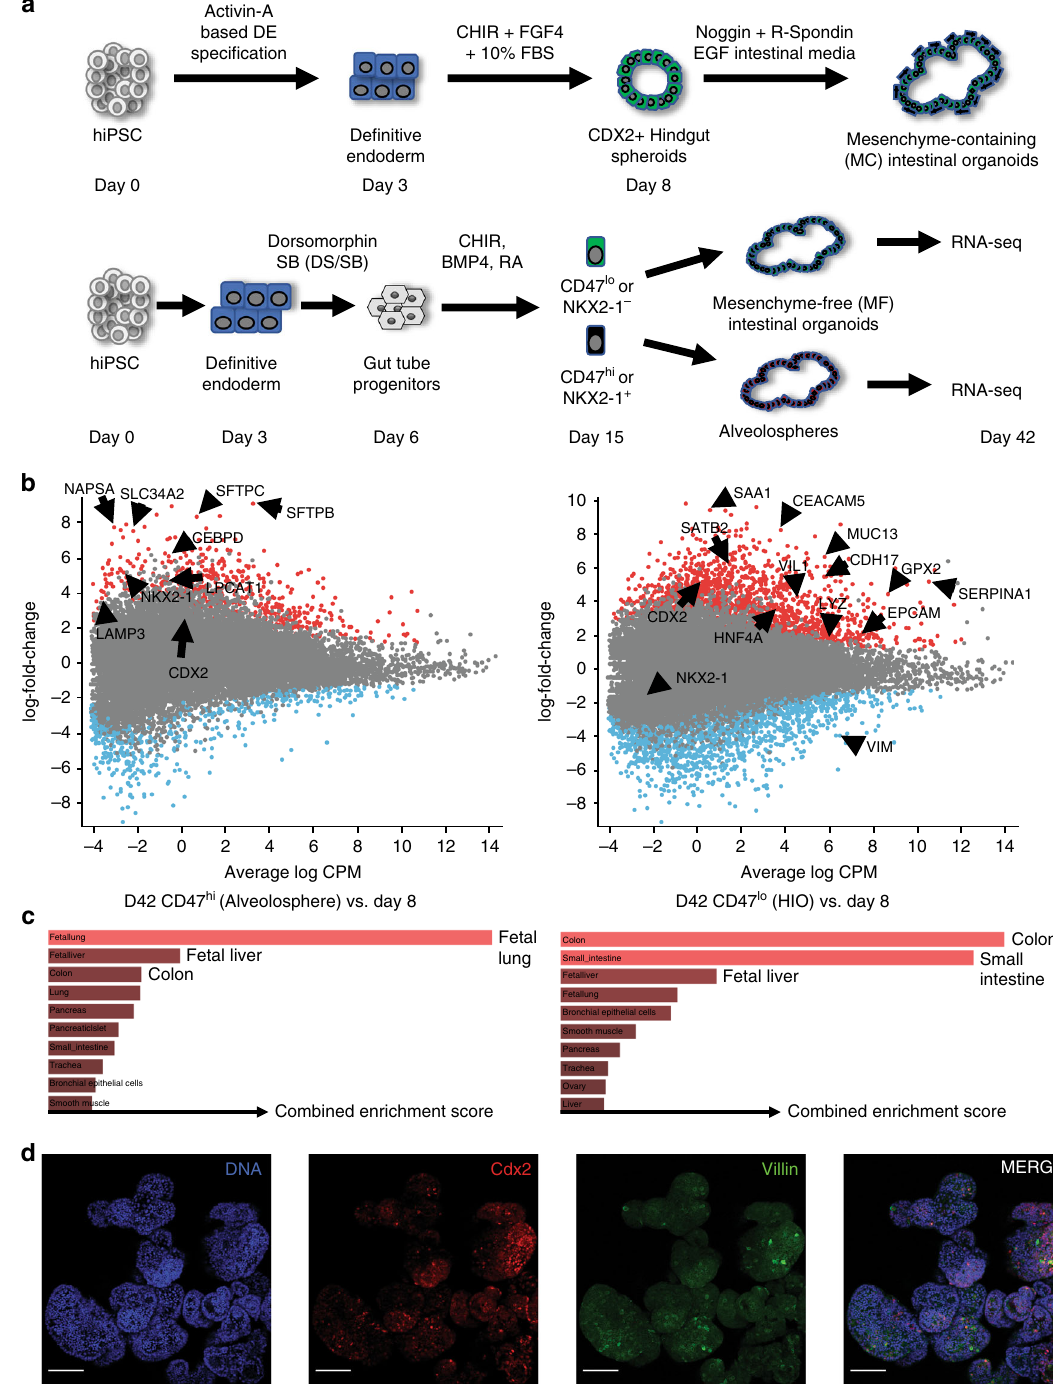
Fig. 1 Emergence of intestinal-competent progenitors from iPSCs. a Schematic of comparison between mesenchyme-containing (MC) HIO vs mesenchyme-free (MF) directed differentiation protocols. b Mean Average (MA) Plots of signi fi cantly differentially expressed genes that were either upregulated (red dots) or downregulated (blue dots) in digital gene expression analysis from day 42 (D42) organoids sorted for CD47 on day 15, comparing the CD47 hi (Alveolospheres, left) and CD47 lo (HIOs, right) cultured in CK-DCI, as compared with day 8 (D8) progenitors ( p -value = <0.05 calculated as described 82 ). c Gene set enrichment analysis using Enrichr analyzing the top tissue types when referenced to the human gene atlas. Length of red bars indicates combined enrichment score. All bars are adjusted p -value = <0.05 calculated as described 28,29 . d Representative micrographs of whole mounts of day 85 organoids derived from BU3NGST NKX2-1 GFPneg sorted outgrowth demonstrate colocalized expression of Cdx2 and Villin (VIL) (scale bar = 50 μ m, representative of n = 3